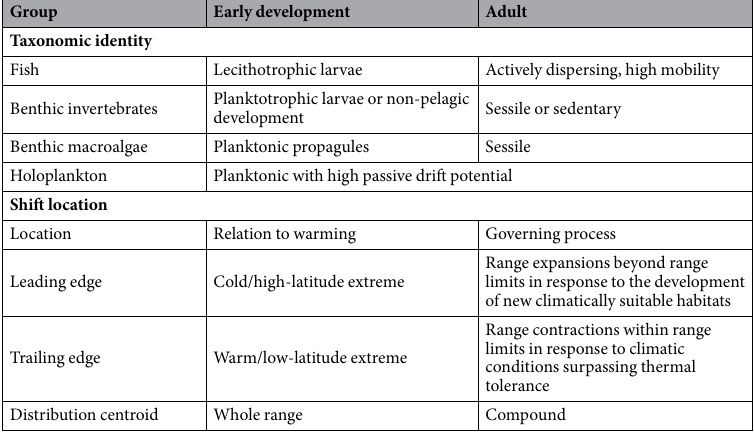
Table 1. Description of the two categorical predictor variables used to predict observed distribution